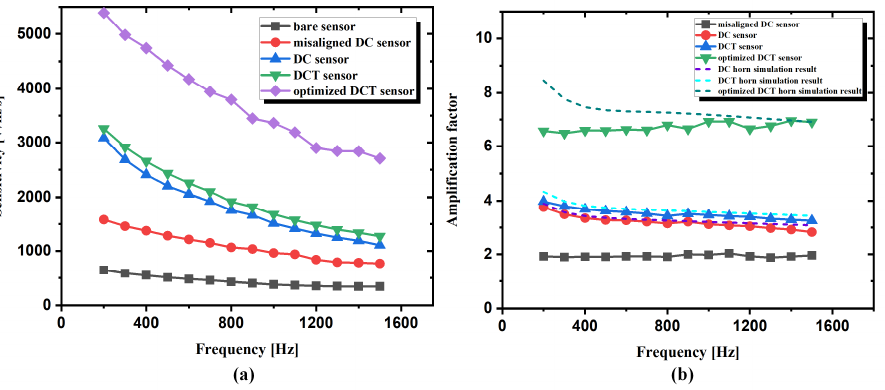
Figure 13. Frequency responses of: ( a ) TAPVS sensitivity with and without acoustic horns with the same designed parameters and ( b ) comparisons of measured and simulated amplification factors of TAPVS with and without acoustic horns.